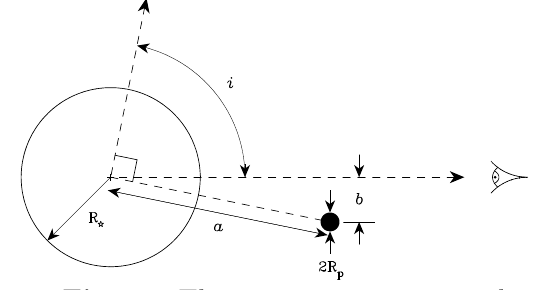
Fig. 10. The important geometrical